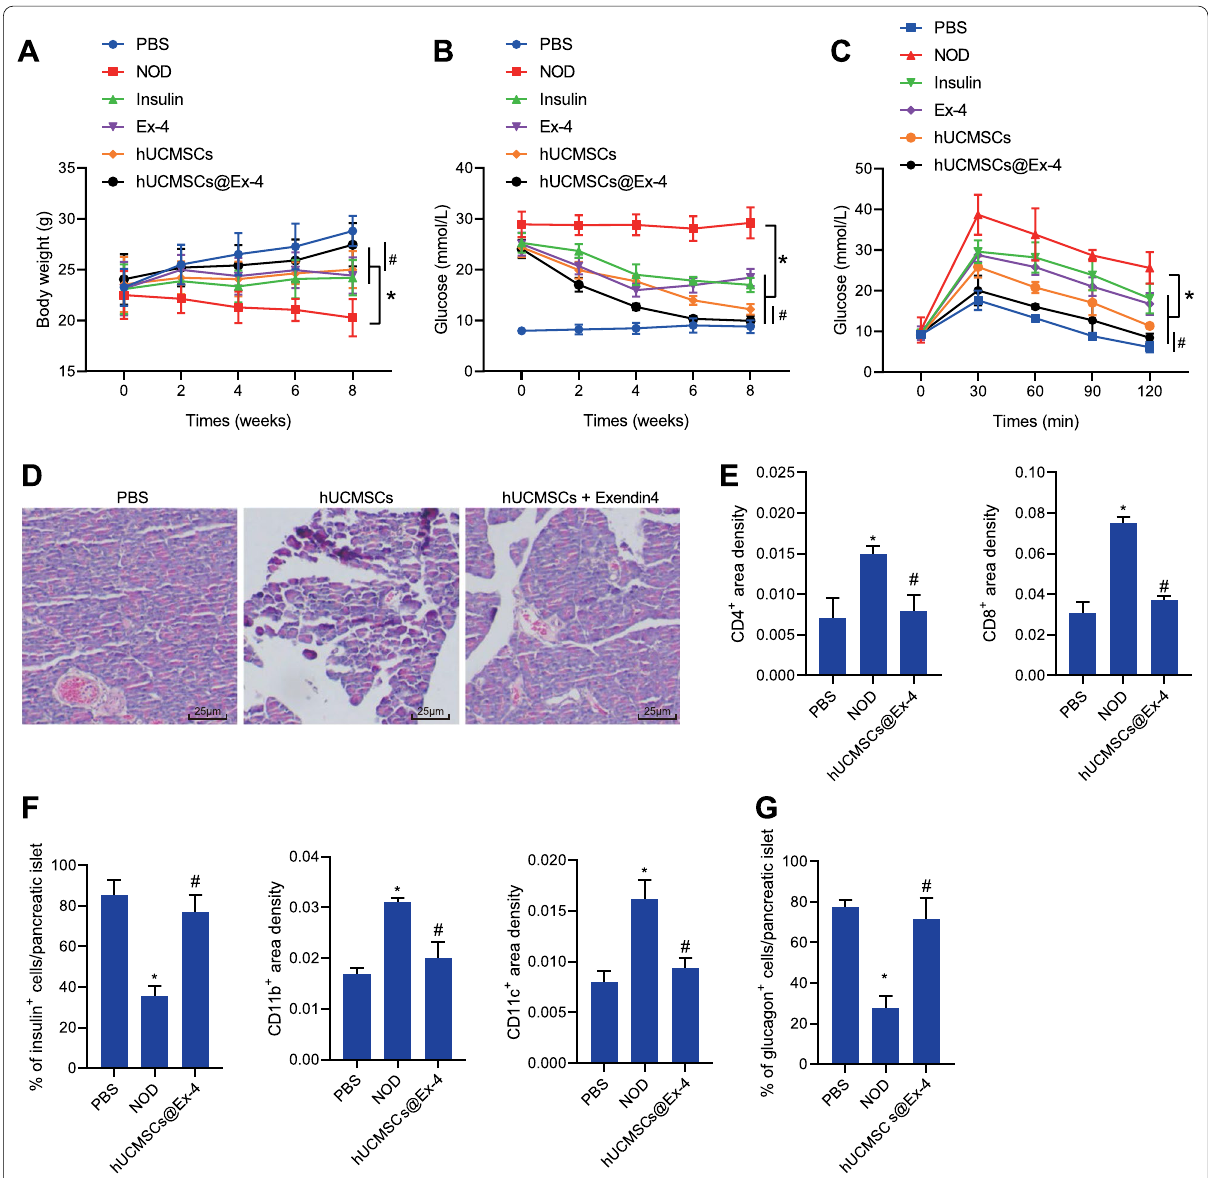
Fig. 1 hUCMSCs@Ex-4 promotes the repair of islet tissue damage by reducing the blood glucose level in NOD mice. A Body weight of NOD mice after different treatments. B Blood glucose level in NOD mice with different treatments. C Blood glucose level in NOD mice with different treatments measured by OGTT. D HE staining for islet morphology in NOD mice with different treatments (400 analysis of the infiltration of immune cells (CD4 + T, CD8 + T, CD11b + , and CD11c + ) in the pancreatic tissues of NOD mice with different treatments. F Proportion of β-cells in the pancreatic tissues of NOD mice with different treatments analyzed by immunohistochemical staining. G Proportion of α-cells in the pancreatic tissues of NOD mice with different treatments analyzed by immunohistochemical staining. In panels A-C, * p < 0.05 vs. NOD mice. # p < 0.05, NOD mice treated with hUCMSCs@Ex-4 vs. NOD mice treated with hUCMSCs. In panels E–G, * p < 0.05 vs. PBS-treated mice. # p < 0.05 vs. NOD mice. n =